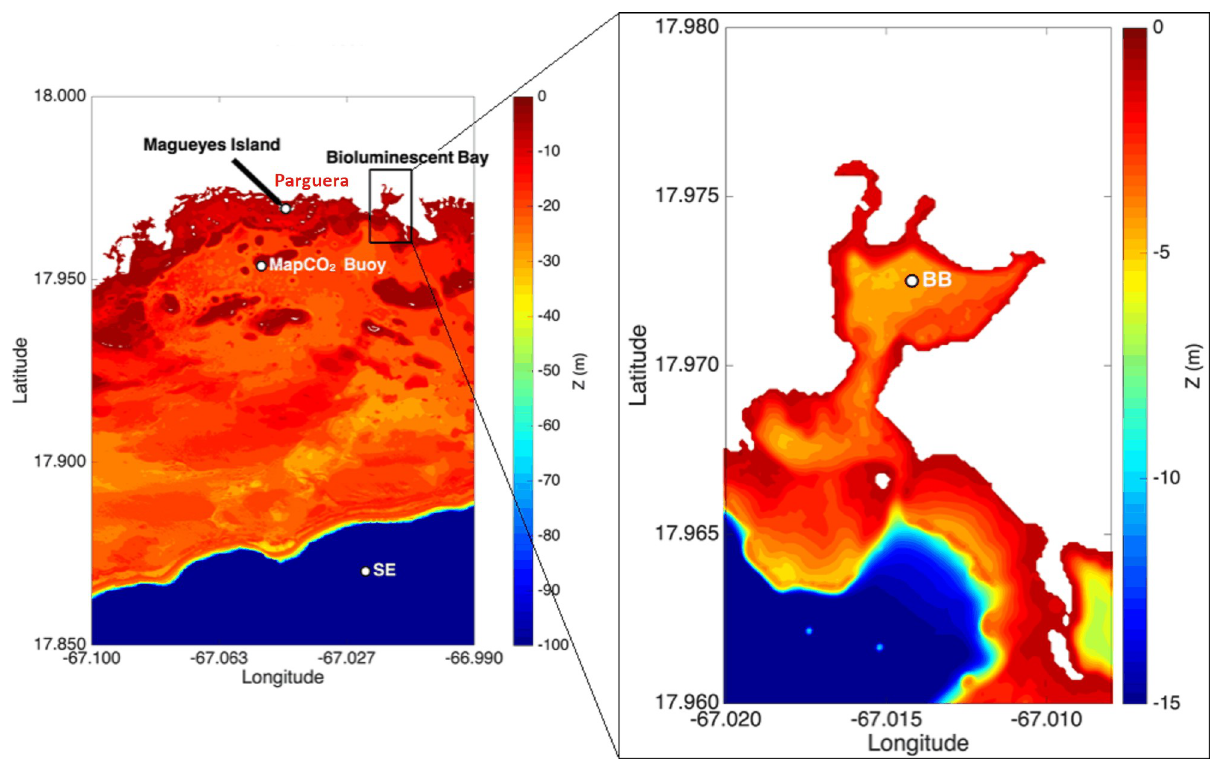
Fig 1. Bathymetric maps of La Parguera Marine Reserve (Lajas, PR) and study sites. La Parguera Marine Reserve is on the left panel. The white dots represent the shelf-edge station (SE), the moored autonomous carbon dioxide partial pressure (Ma p CO 2 ) buoy, and the Marine Station (Magueyes Island). The Bioluminescent Bay is to the right, and the white dot represents the sampled station (BB). Note the corresponding depth color legend to the right of each map.